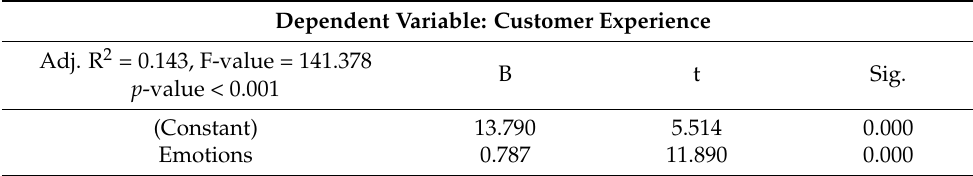
Table 6. Step 2. Second simple regression equation of the mediation analysis.